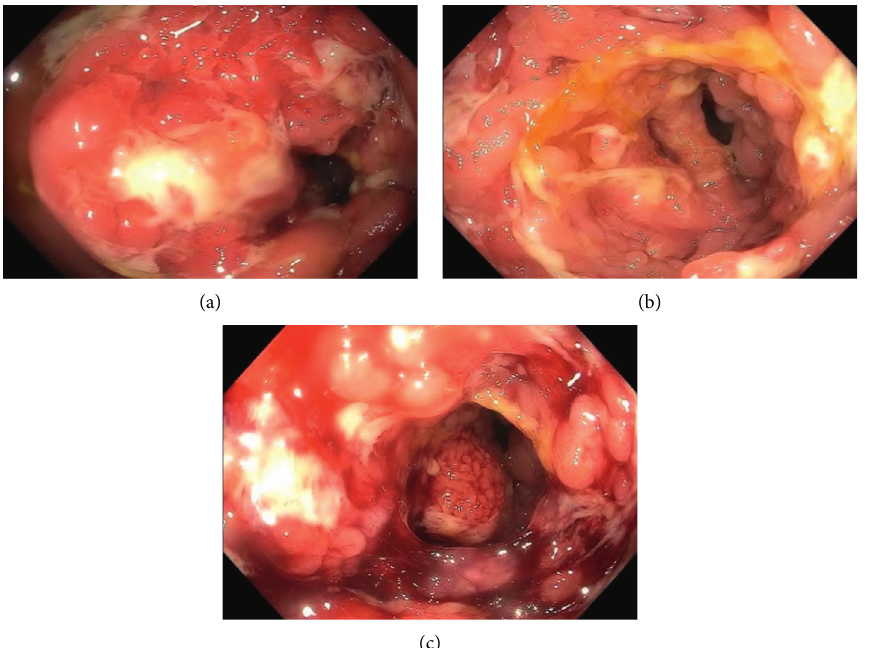
Figure 1: Colonoscopic findings of the hepatic flexure, demonstrating circumferential inflammatory and stenotic mass.